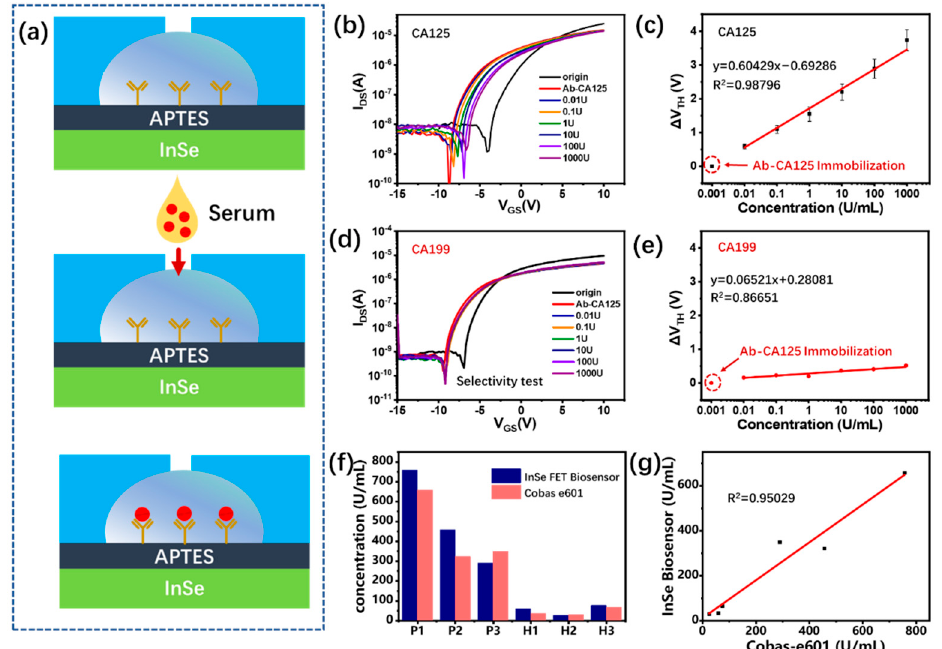
Figure 5. ( a ) Schematic diagram of InSe-FET biosensor for biomarker detection. ( b ) Transfer charac- teristic responses to target CA125 antigen in different concentrations. ( c ) Quantitative relationship between threshold voltage shift and antigen CA125 concentration. ( d ) Transfer characteristics re- sponses to the non-target antigen CA199, and ( e ) threshold voltage shift corresponding to different concentrations of antigen CA199. ( f ) Comparison of the results of antigen CA125 detection by InSe- FET biosensor and Cobas Roche electroluminescence assay on serum samples from breast cancer patients and healthy individuals. P1~3 are serum samples from three breast cancer patients, and H1~3 are serum samples from three healthy people. ( g ) Correlation of the results of the proposed InSe-FET biosensor with those of the Cobas e601 electroluminescence device. The specificity of CA125 detection is performed by loading different concentrations of CA199 to the CA125 antibody immobilized channel. Figure 5d shows the negligible